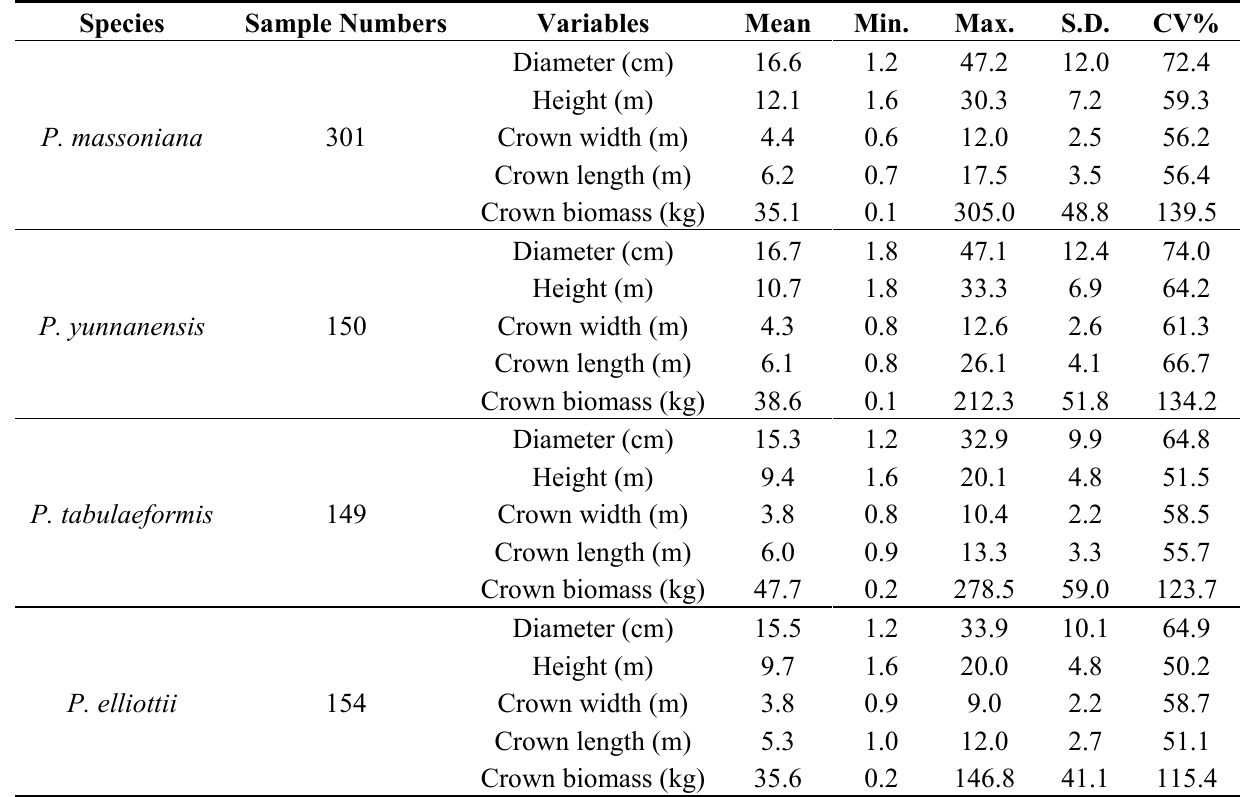
Table 1. Individual tree crown biomass modeling sample data